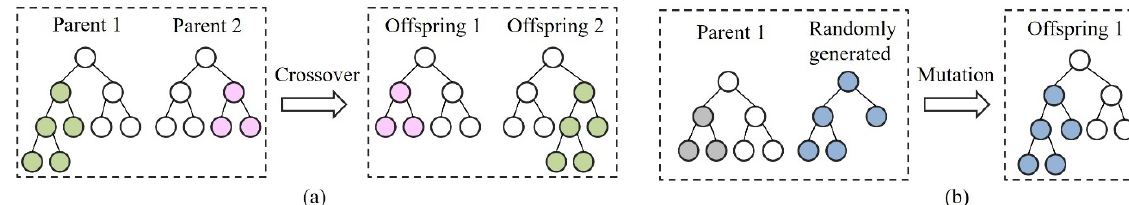
Figure 7. Schematic of crossover ( a ); and mutation operations ( b ).